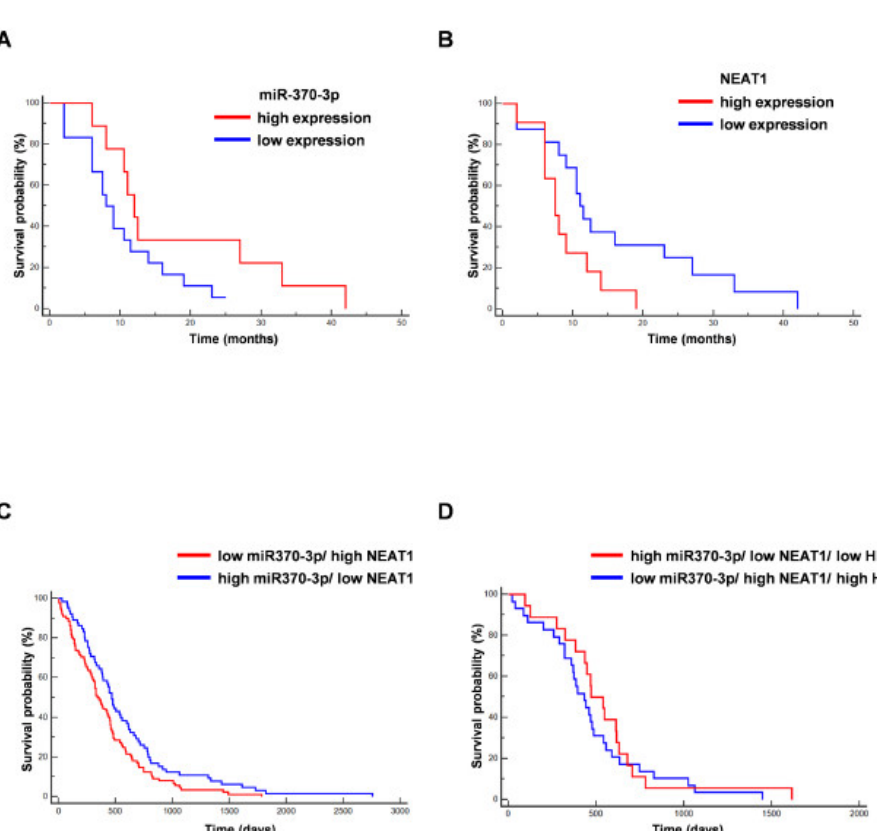
Figure 5. Correlation between miR-370-3p and NEAT1 expression and overall survival (OS) of GBM patients. ( A ) Kaplan–Meier curve for OS in our cohort of GBM patients stratified for low miR-370-3p expression ( < the median value) vs high miR-370-3p expression ( > the median value). The last group was not associated to a better outcome ( n = 27, p = 0.09, Hazard Ratio (HR) 0.4778, 95% CI from 0.2029 to 1.1253). ( B ) Kaplan–Meier curve for OS in our cohort of GBM patients stratified for low NEAT1 expression ( < the median value) vs. high NEAT1 expression ( > the median value). The last group was significantly associated to a worse outcome ( n = 27, p = 0.035, HR 2.7980, 95% CI from 1.0754 to 7.2804). ( C ) Kaplan–Meier curve for OS in GBM The Cancer Genome Atlas (TCGA) patients stratified for low miR-370-3p / high NEAT1 vs. high miR-370-3p / low NEAT1. The last group was significantly associated to a better outcome ( n = 153, p = 0.0215, HR 0.6855, 95% CI from 0.4968 to 0.9458). ( D ) Kaplan–Meier curve for OS in GBM TCGA patients stratified for low miR-370-3p / high NEAT1 / high HIF1A vs high miR-370-3p / low NEAT1 / low HIF1A ( n = 47, p = 0.4400, HR 0.7927, 95% CI from 0.4395 to